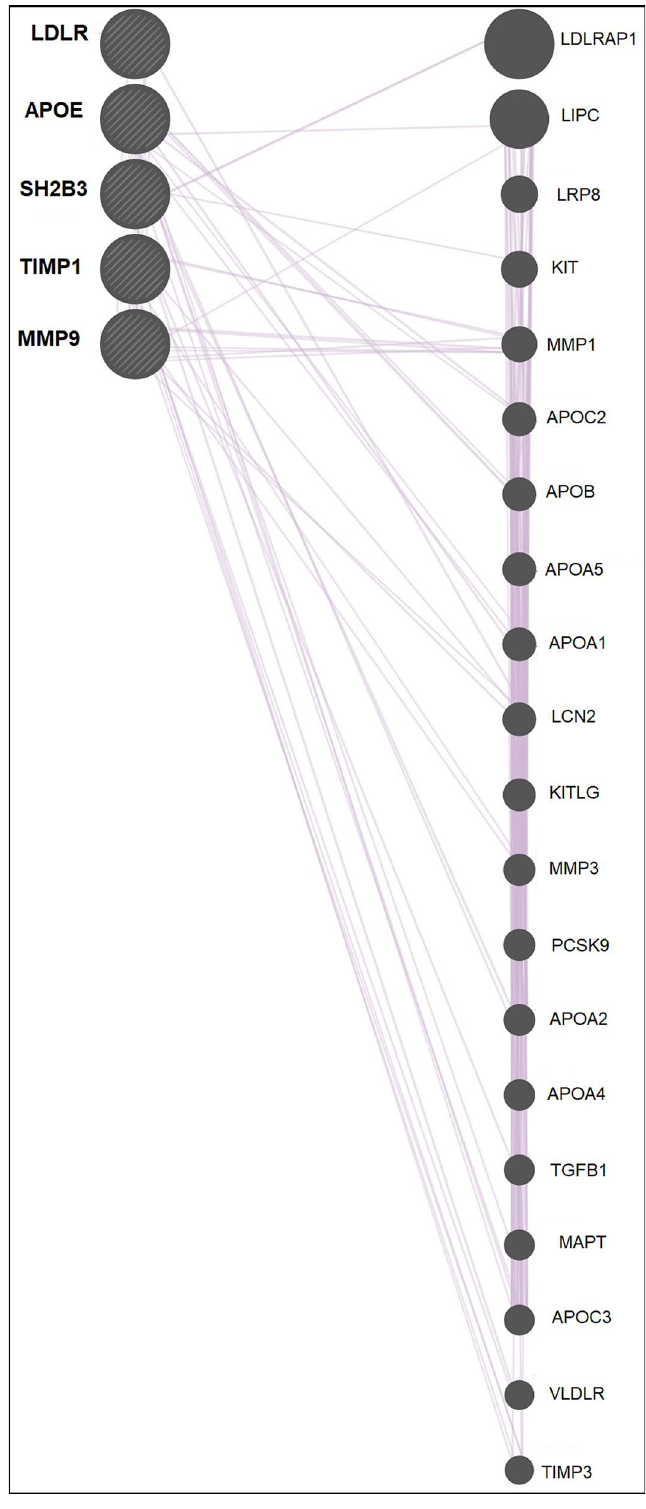
Figure 5. Linear bipartite by GeneMANIA represents Co-expression networks of multi gene queries for APOE , LDLR , MMP9 , SH2B3 and